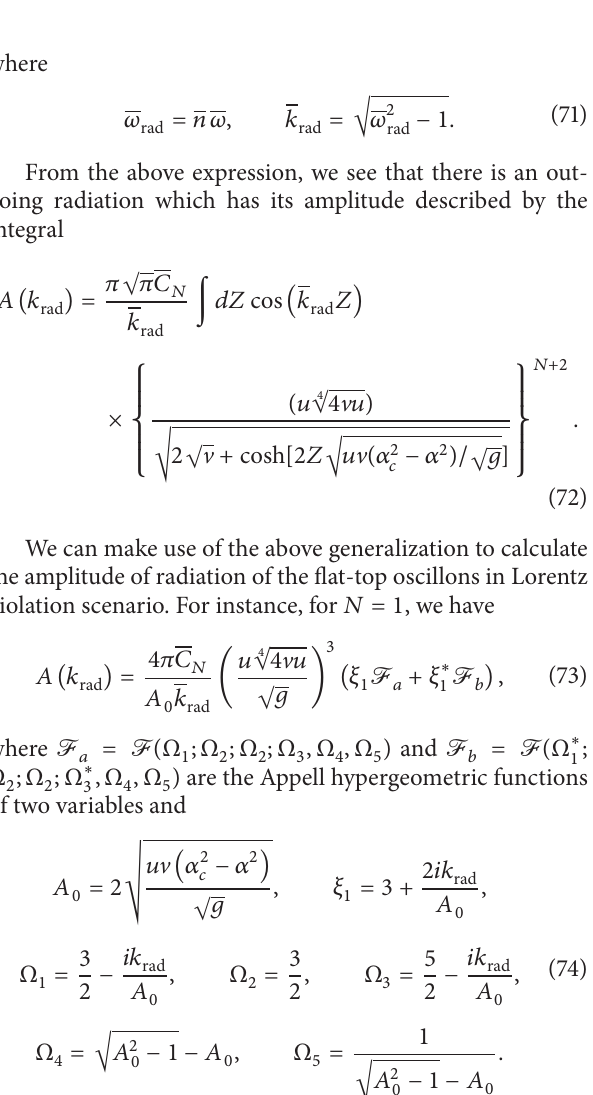
Figure6:AmplitudeoftheoutgoingradiationdeterminedbytheFouriertransform.Theleft-handfigurecorrespondstothecasewithLorentz breaking symmetry and the right-hand to the case with Lorentz